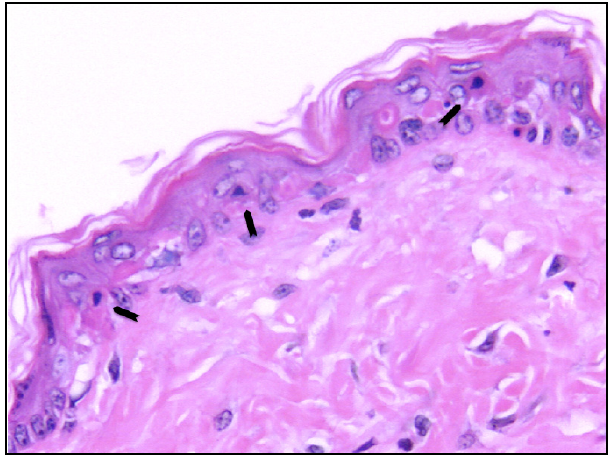
Figure 1. Typical histology of Skh:hr1 mouse skin showing “sunburn cells” or apoptotic keratinocytes, as indicated by black arrows. Sunburn cells are recognised by their pyknotic nucleus and eosinophilic